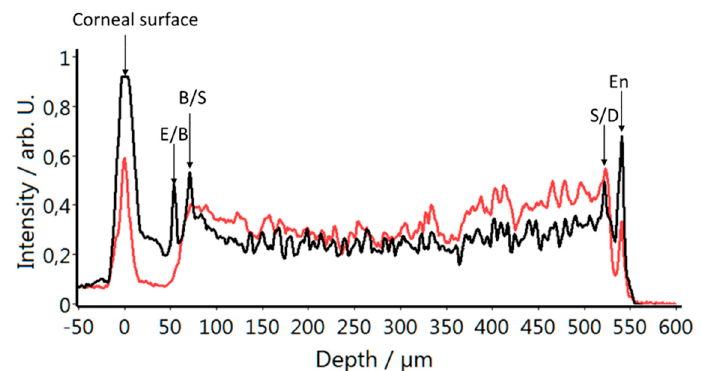
Figure 4. Averaged depth profiles of the central 100 A-scans of the images displayed in Figure 3. Black indicates the co-polarized, red the cross-polarized detection channel. The arrows point to the different corneal interfaces. E (epithelium), B (Bowman’s layer), S (stroma), D (Descemet’s membrane), En (endothelium).